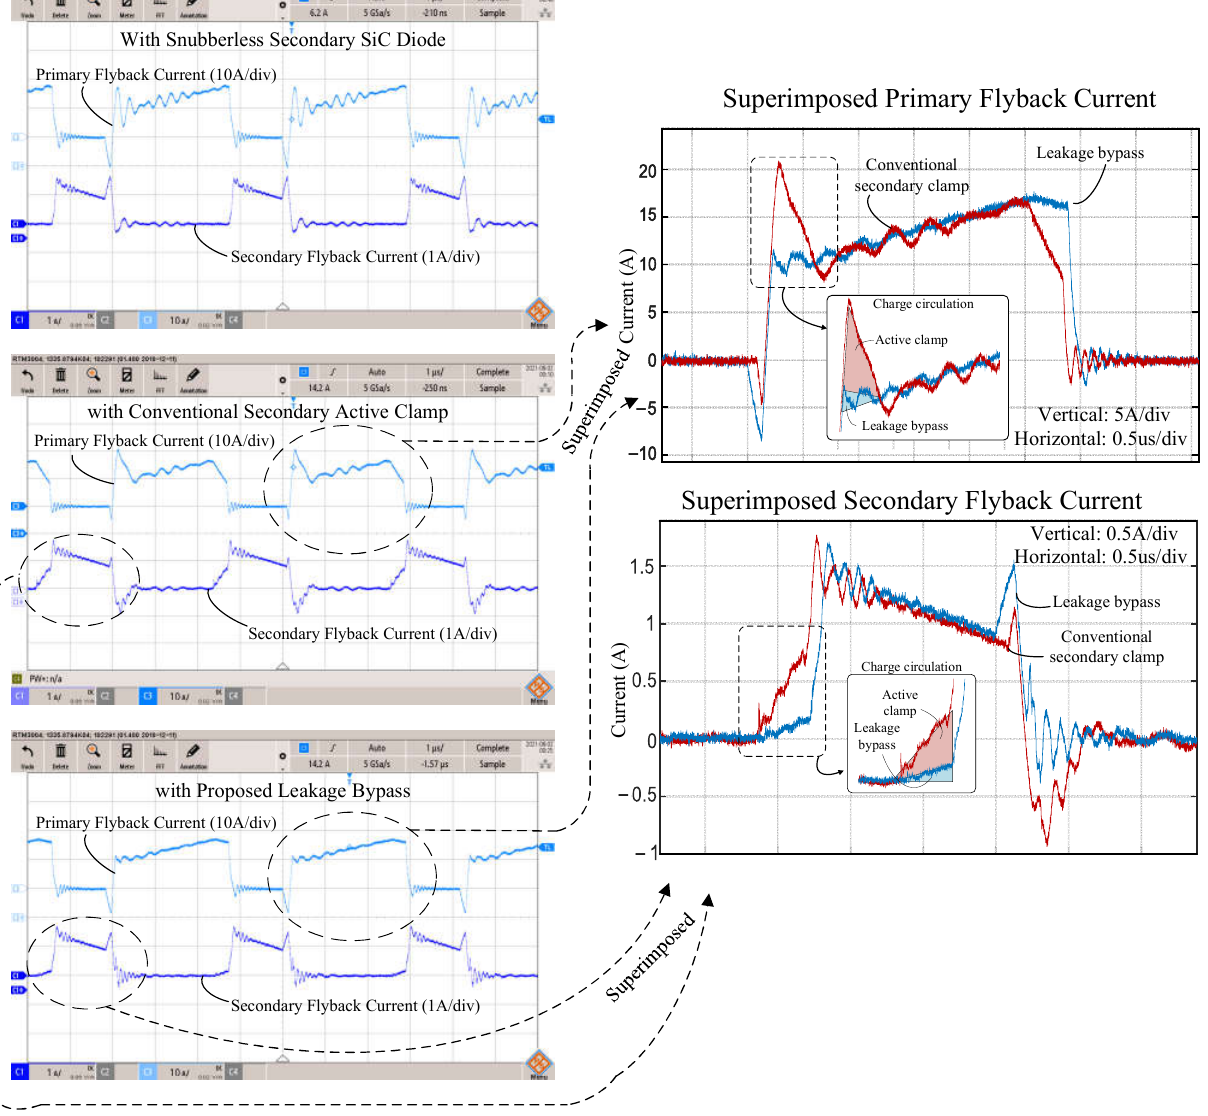
Figure 18. Experimental result of flyback transformer current.